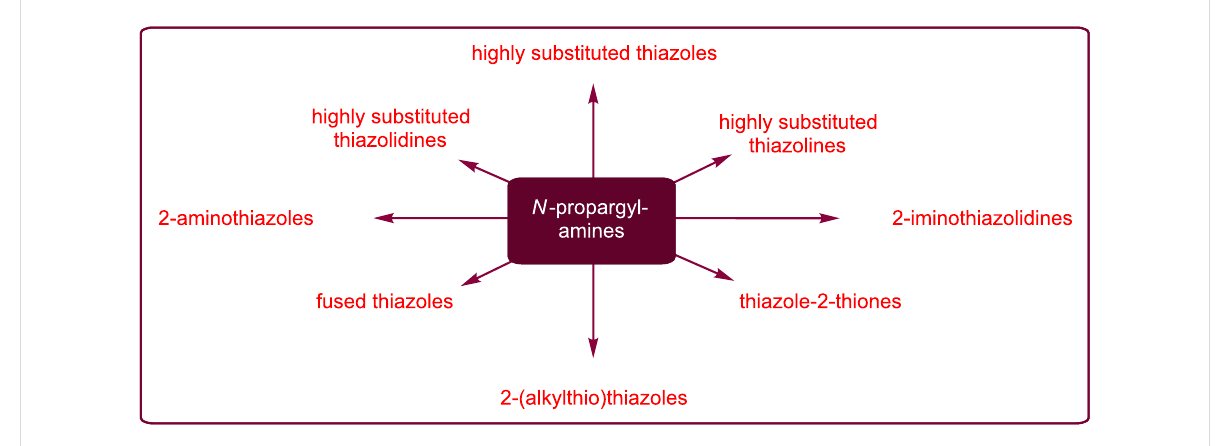
Figure 3: Some important thiazole-based compounds derived from N -propargylamines.